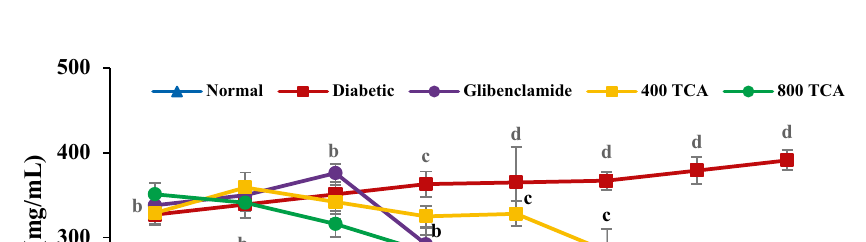
Figure 2. Effect of T. catappa aqueous extract treatment on HFD/STZ-induced diabetic rats body weight changes during the experimental period. Markers were expressed as mean ± SEM (n = 6). Markers with different superscripts for a given week are significantly different at p < 0.05. Markers without superscripts for a given week are significantly different at p < 0.05.